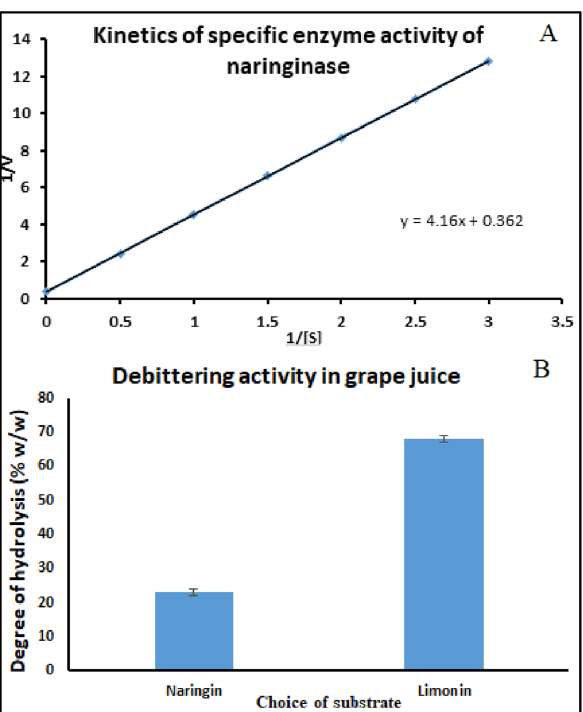
Figure 6. Graphical plots representing ( A ) Enzyme activity kinetics of naringinase and ( B ) debittering activity of ultrapure enzyme in grape